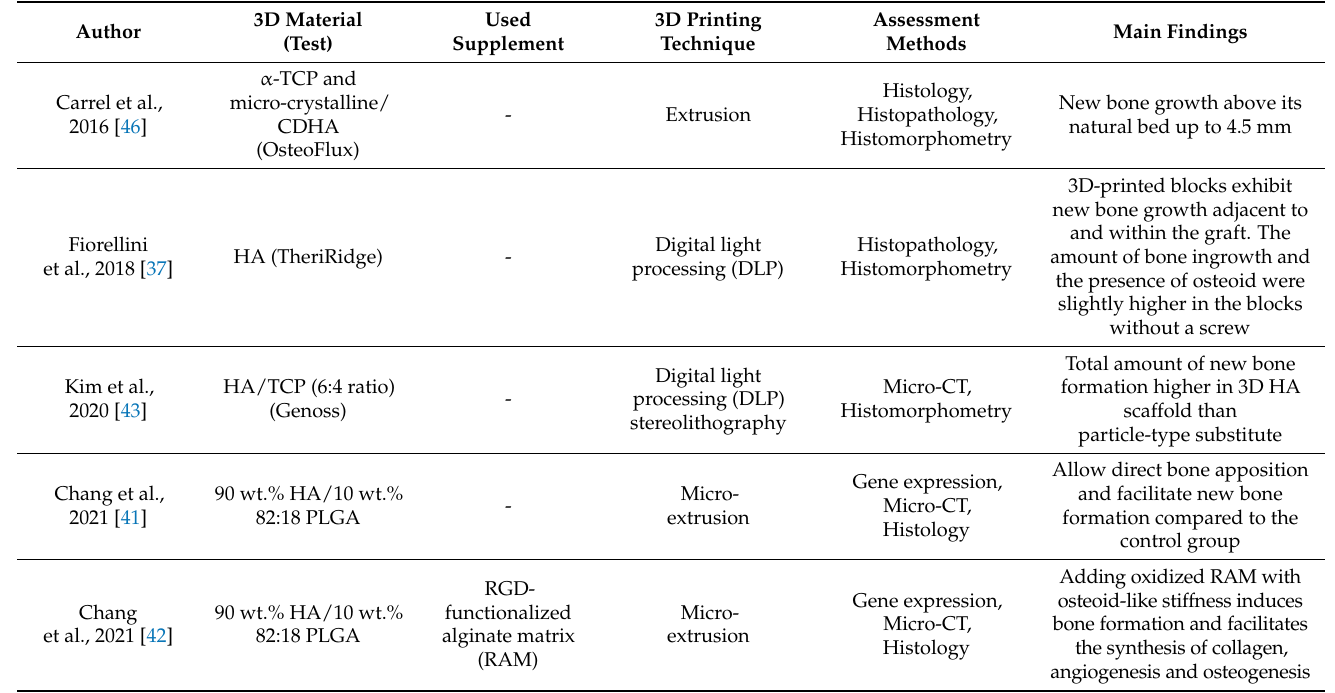
Table 1. Summary of the included studies using 3D HA-based scaffolds.